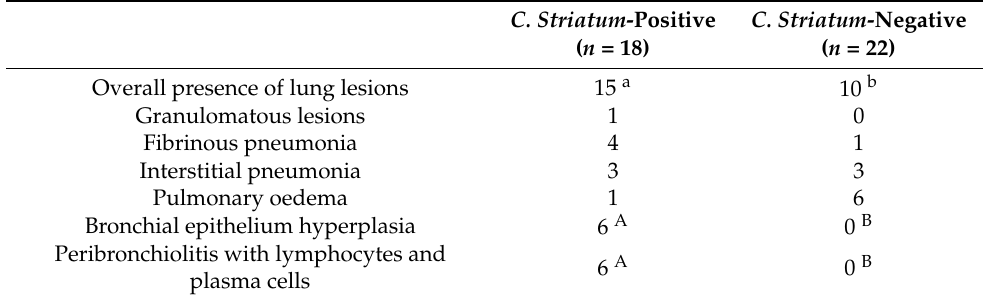
Figure 4. European hedgehog, lung. Sections of adult C. striatum nematodes in the lumen of a bronchus (arrows), associated with hyperplasia (asterisks) of the bronchial epithelium. Hematoxylin and Eosin (HE). Table 2. Comparison between presence of pulmonary and bronchial histological lesions in C. striatum - positive and -negative hedgehogs. A,B : p < 0.01; a,b : p <